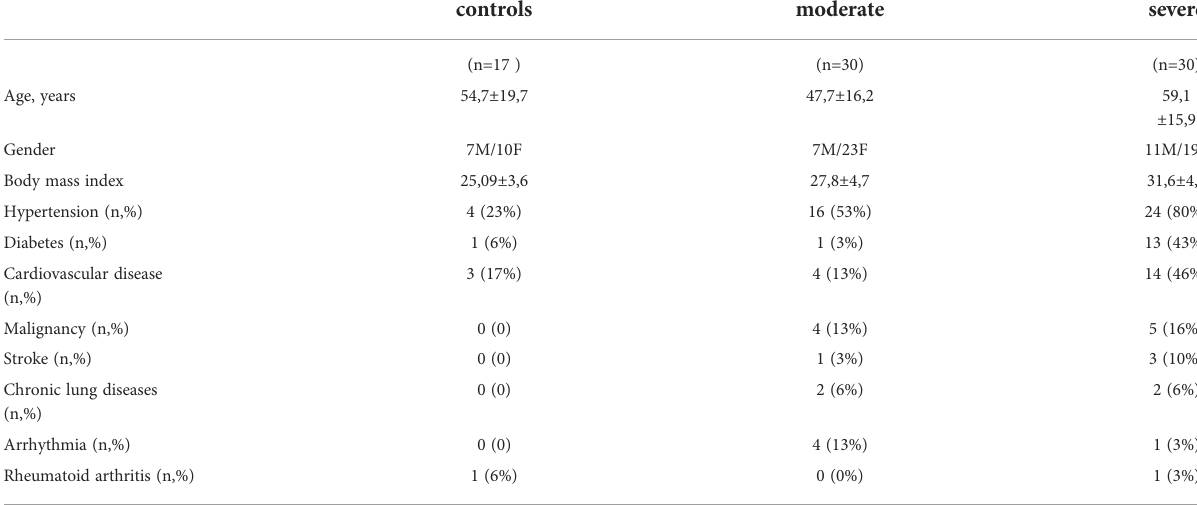
TABLE 1 Demographics and baseline characteristics of patients included in the